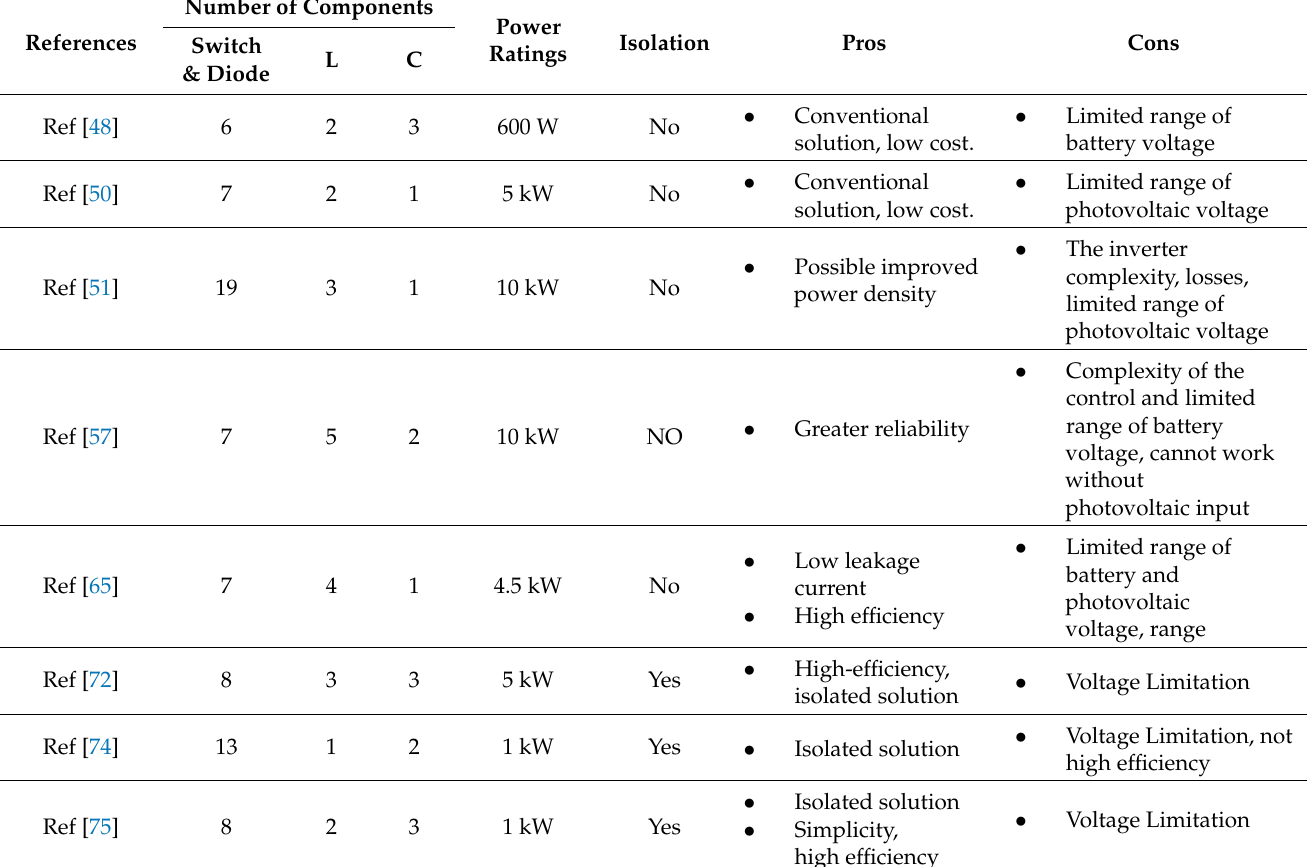
Table 2. Summary of hybrid solutions.